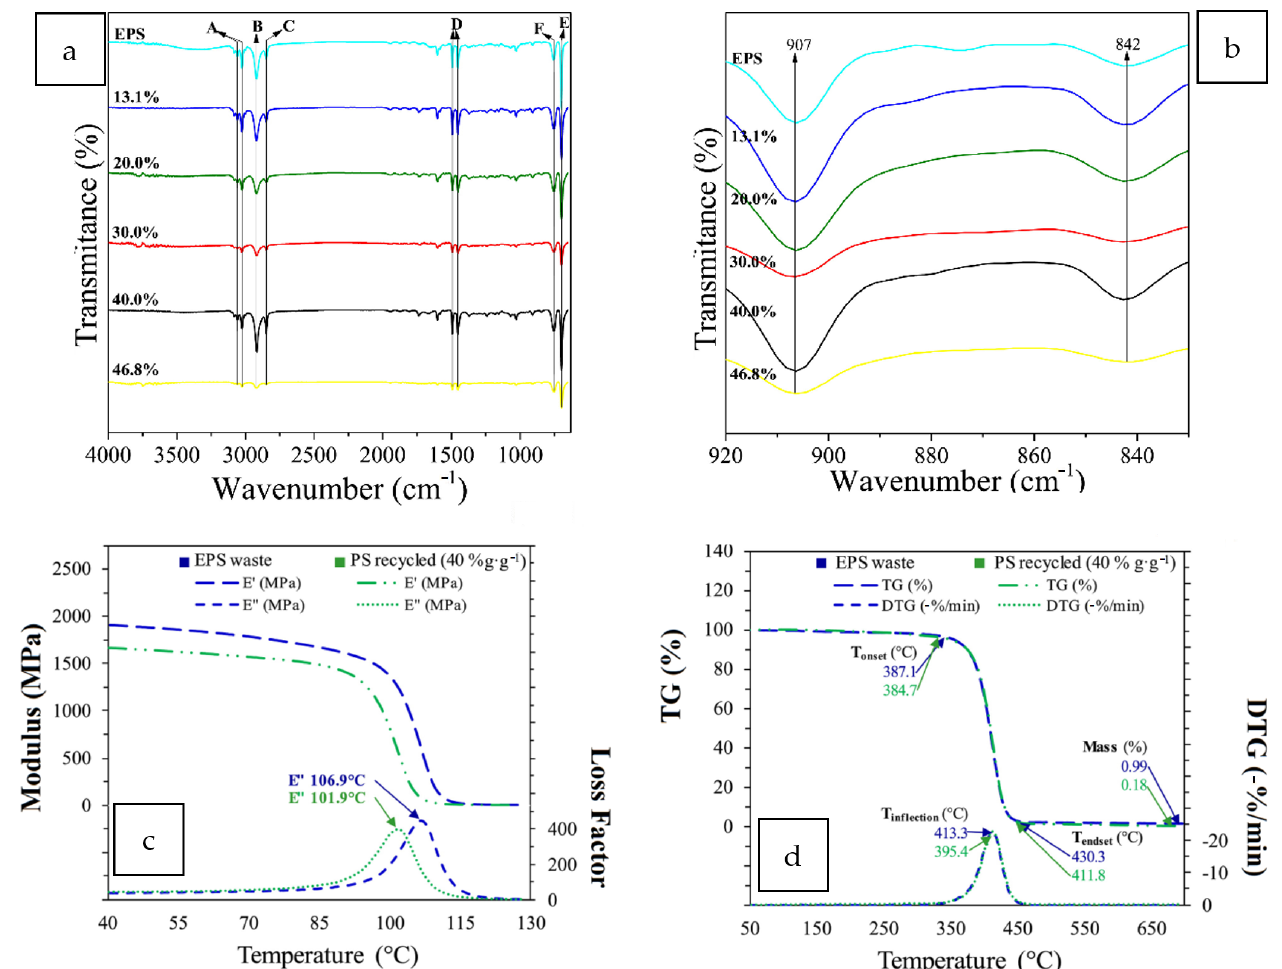
Figure 16. Comparison of ( a ), ( b ): Chemical (via FTIR), ( c ): Thermal (through % weight loss thermo- gravimetry TG and first derivative differential thermogravimetry DTG data), and ( d ): Mechanical (Storage Modulus E’ (in MPa) and Loss Modulus E’’ (in MPa)) characteristics of regenerated PS with source EPS. Reprinted with permission from Ref. [50].